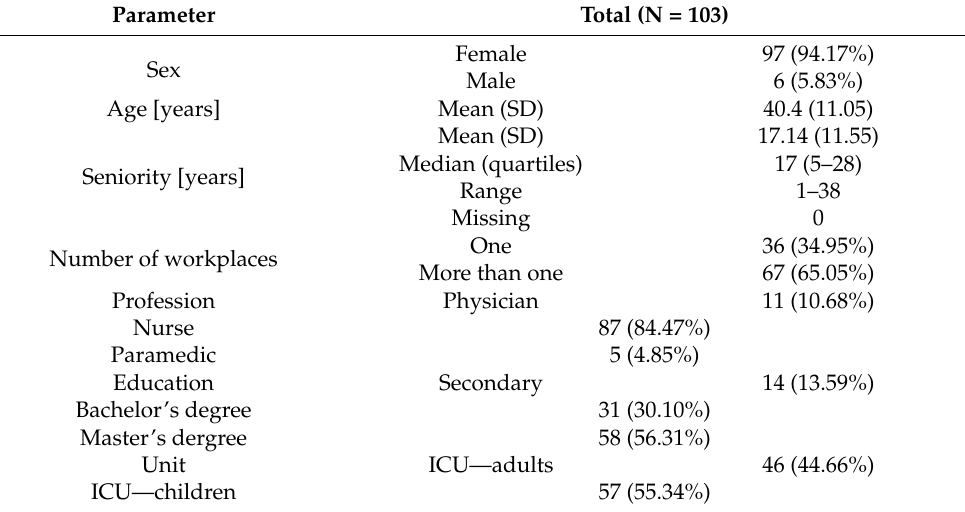
Table 2. Socio-demographic characteristics of the study sample (N = 103).